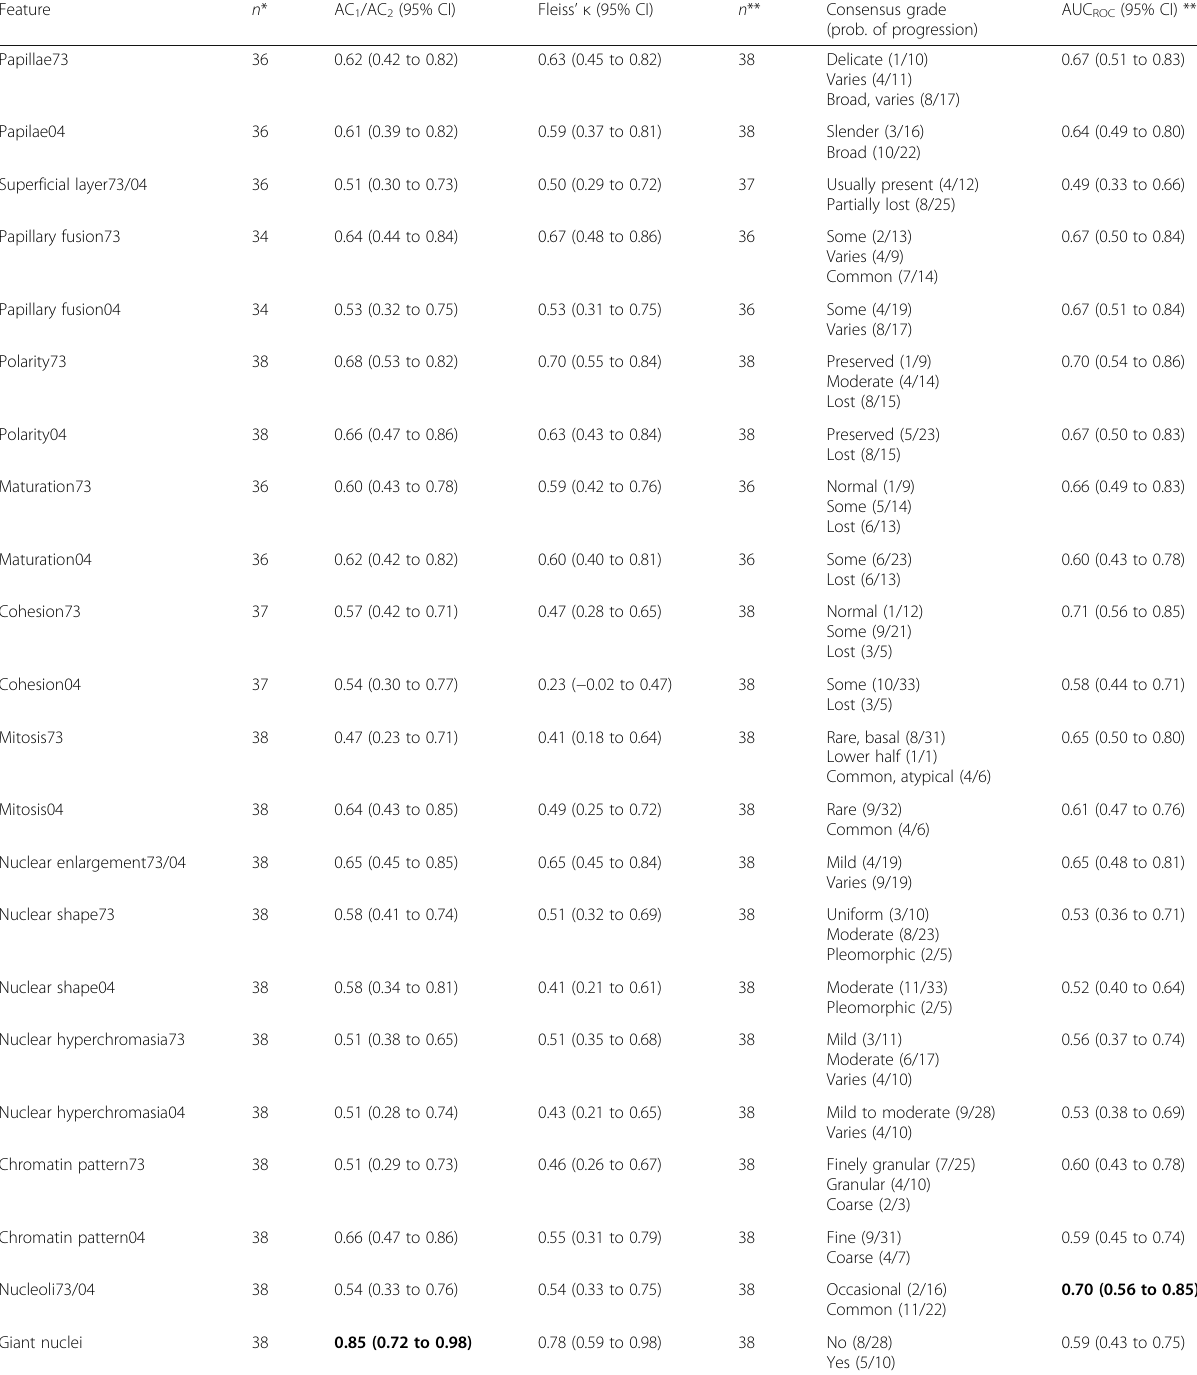
Table 2 Reproducibility and prognostic value for each of the microscopic characteristics